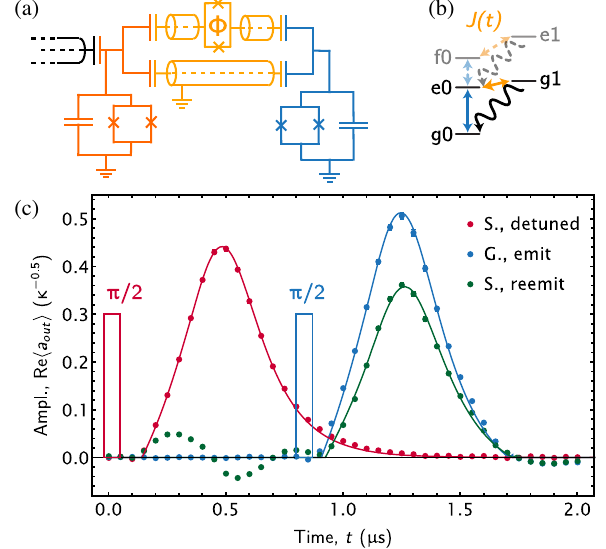
FIG. 2. (a) Electrical circuit diagram of the gate qubit (blue) interacting with fields in the transmission line (black) through a tunable coupler (orange) and a converter mode (dark orange, realized as a transmon qubit). (b) Energy-level diagram indicating transitions induced by single-qubit gates (blue), parametric modulation of the flux Φ threading the SQUID loop embedded in the coupler (orange), and photon emission via spontaneous decay (black). (c) Measured (dots) and simulated (solid lines) real i vs time t for part of the envelope of the field amplitude Re h a ffiffiffi p out 2 superposition states ðj 0 i þ j 1 iÞ = qubit with the converter mode of the gate device being detuned from the field (red), when absorbing and reemitting the field at the gate qubit (green), and when directly preparing and emitting the state at the gate qubit (blue). A red (blue) wire frame shows the timing of qubit pulses with a rotation angle of π = 2 applied to the source (gate) qubit prior to emission. Imaginary parts (not ffiffiffi p κ shown) are below 0 . 07 = in